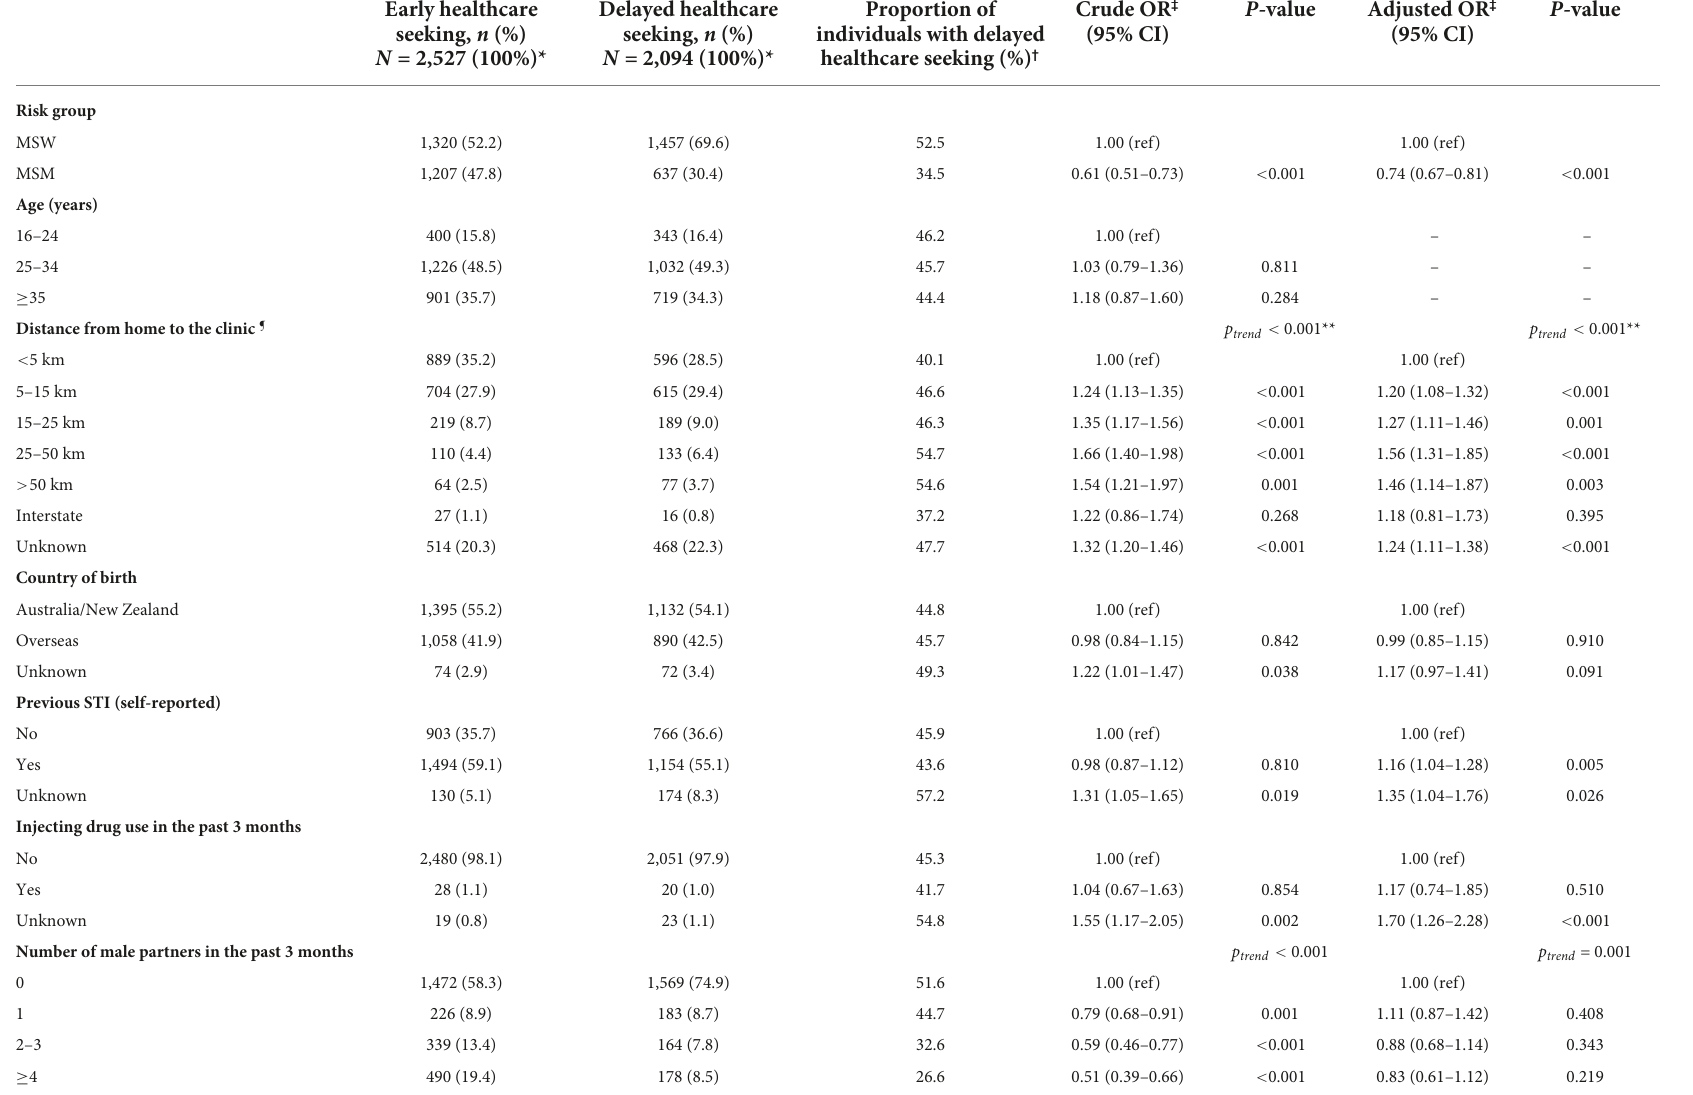
TABLE 2 Factors associated with delayed healthcare seeking ( > 7 days) among 4,621 symptomatic men attending the Melbourne Sexual Health Centre, 10 August 2017 to 31 December